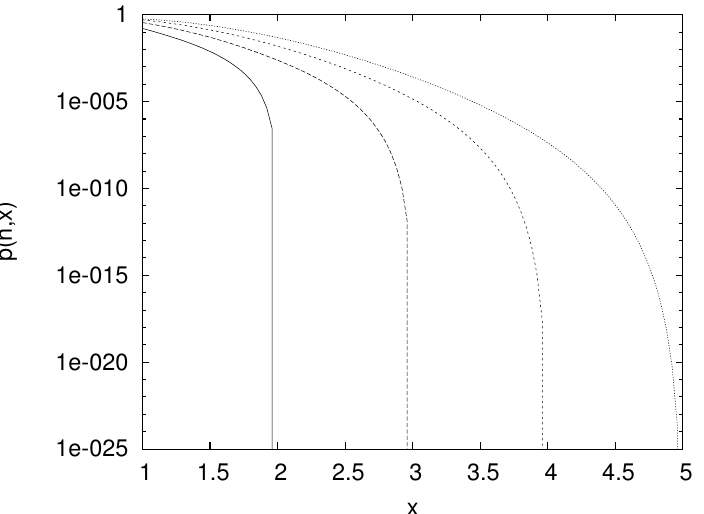
Figure 3. Probabilities p n ( x ) , which are different from zero in the interval 1 < x < n .